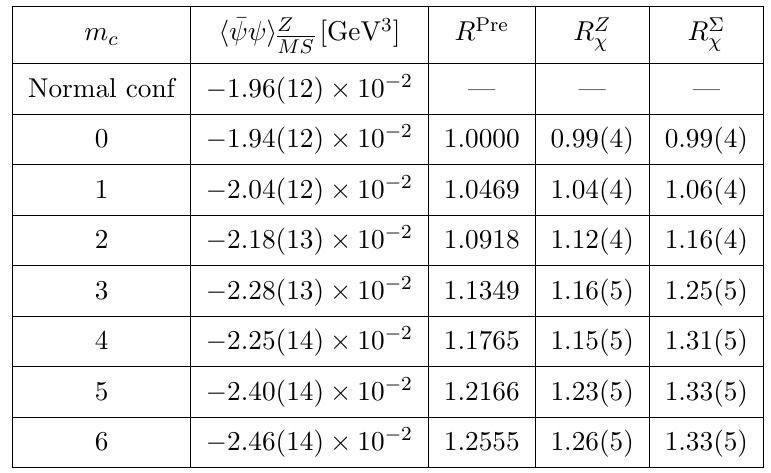
Table 14 . The renormalized chiral condensate h (cid:22) i Z chiral condensates R Z